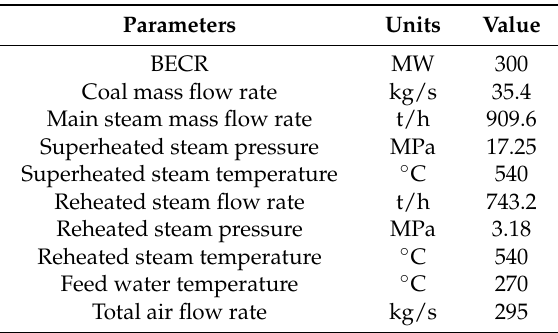
Table 1. Boiler main operation values.